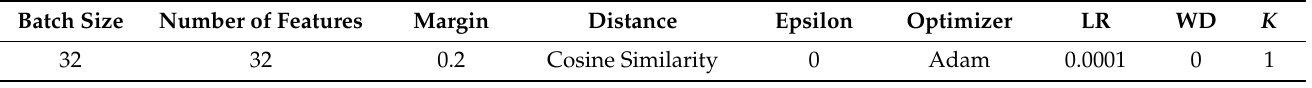
Table 7. The parameters related to the